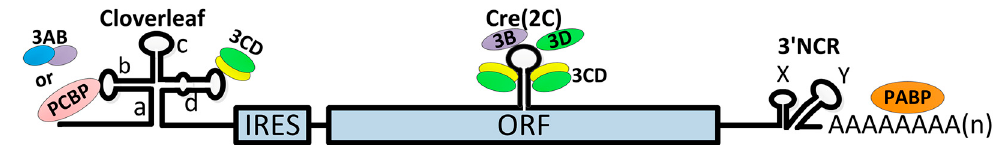
Figure 3. The RNA structures and proteins involved in PV RNA replication [46]. The a, b, c and d subelements form the cloverleaf structure. And the 3’NCR of RNA consists of two stem-loops (X, Y).There are three structures that can interact with 3C pro and its precursor: namely the 5 1